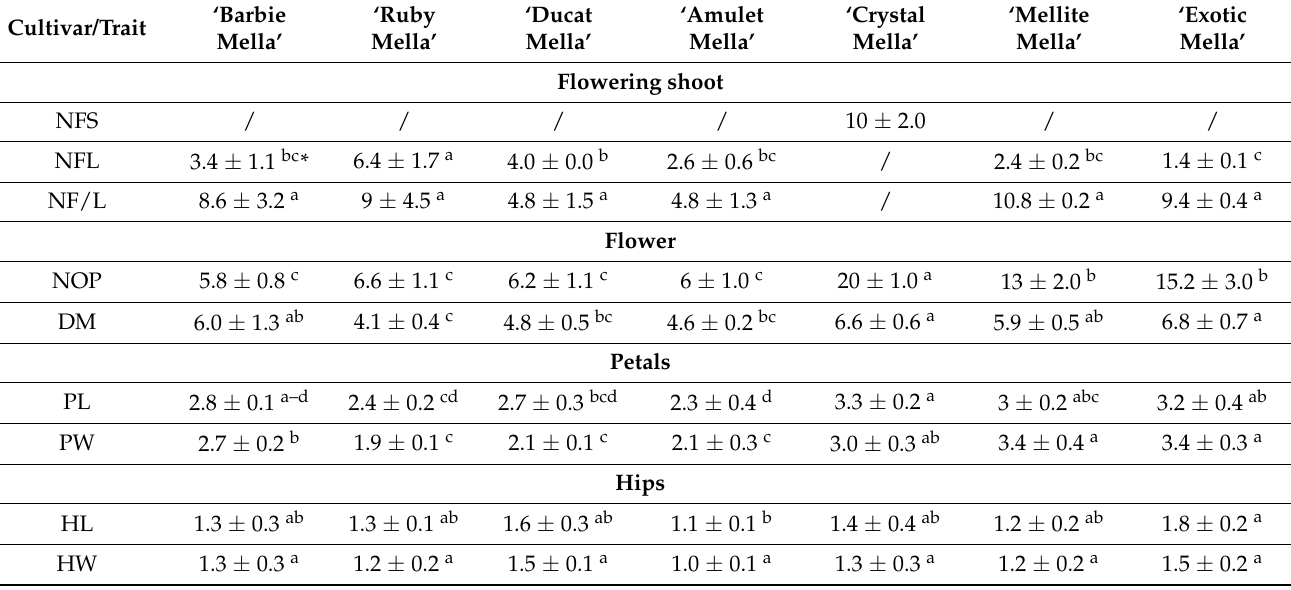
Table 4. Quantitative generative characteristics of the investigated ‘Mella’ rose collection. ‘Ruby ‘Ducat ‘Amulet ‘Crystal ‘Mellite ‘Exotic Mella’ Mella’ Mella’ Mella’